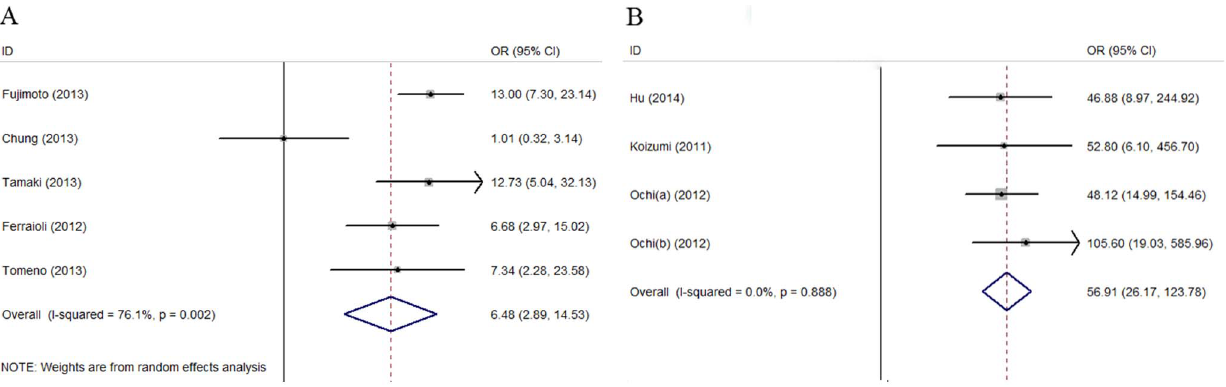
Fig. 2. Forest plot from meta-analysis of DOR value using a random-effect or fixed-effect model for significant fibrosis. (A) Forest plot of LFI and (B) Forest plot of ER1. DOR: diagnostic odds ratio; LFI: liver fibrosis index; ER1: the elastic ratio of the liver for the intrahepatic vein; Ochi (a): the training set of the subjects in the study by Ochi et al; Ochi (b): the validating set of the subjects in the study by Ochi et al.